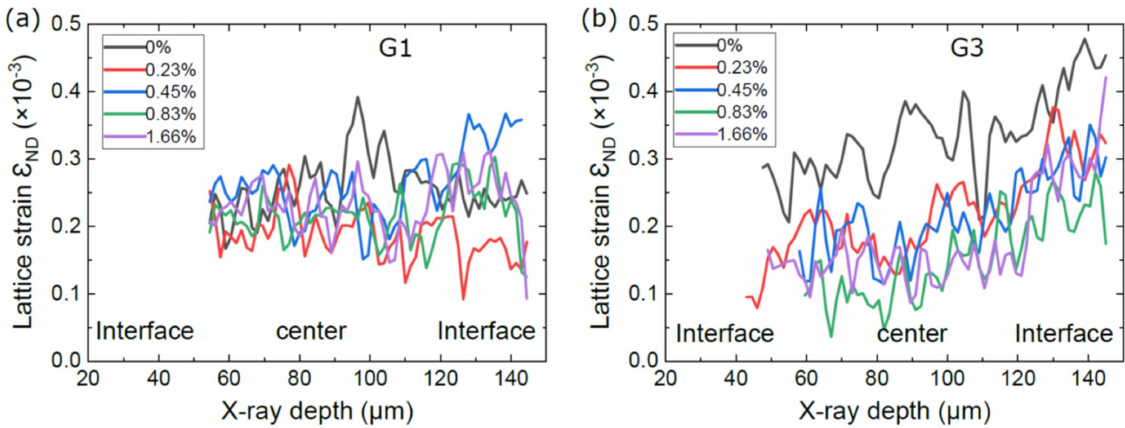
Figure 8. Depth-resolved lattice strain ε ND in two Al grains before and after tensile deformation to different strains. ( a ) In grain G1; ( b ) in grain G3. The strain accuracy of the technique is 1 × 10 − 4